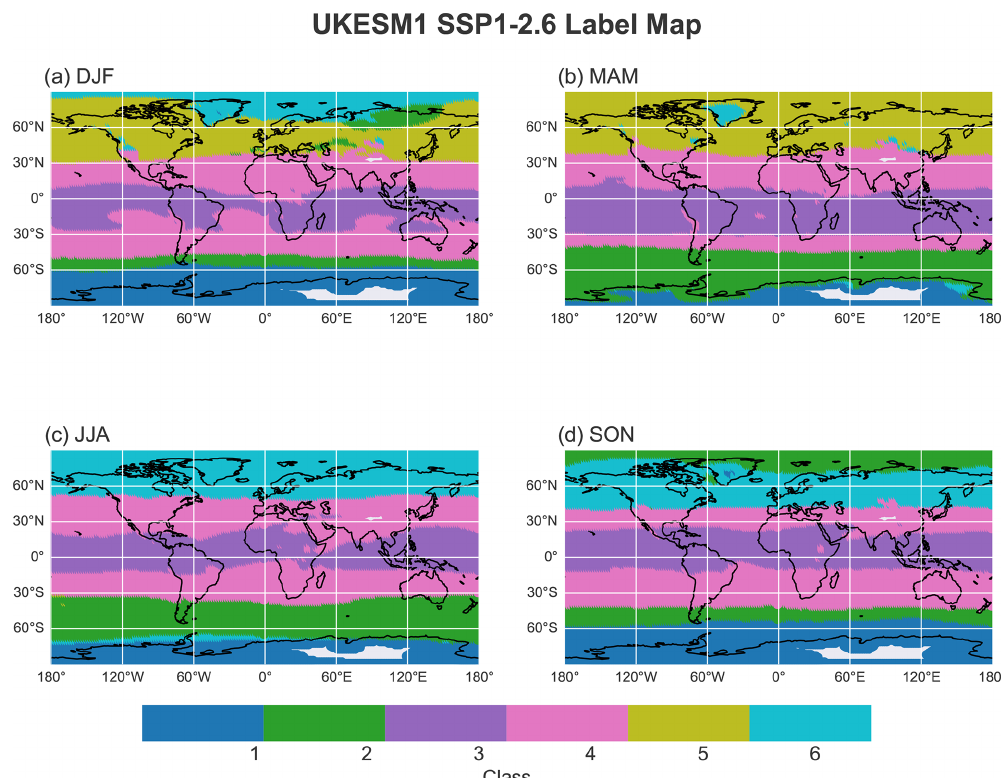
Figure 4. The same as Fig. 3 but for the SSP 1.2-6 label map covering the years 2095–2100.